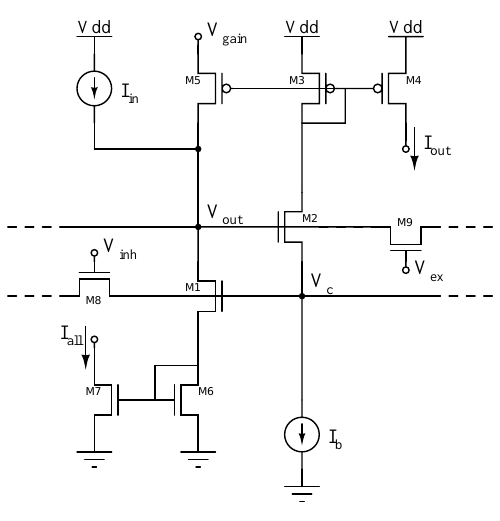
Figure 4 . Hysteretic WTA circuit diagram, with local excitatory feedback, lateral excitatory coupling, lateral inhibitory coupling and diode-source